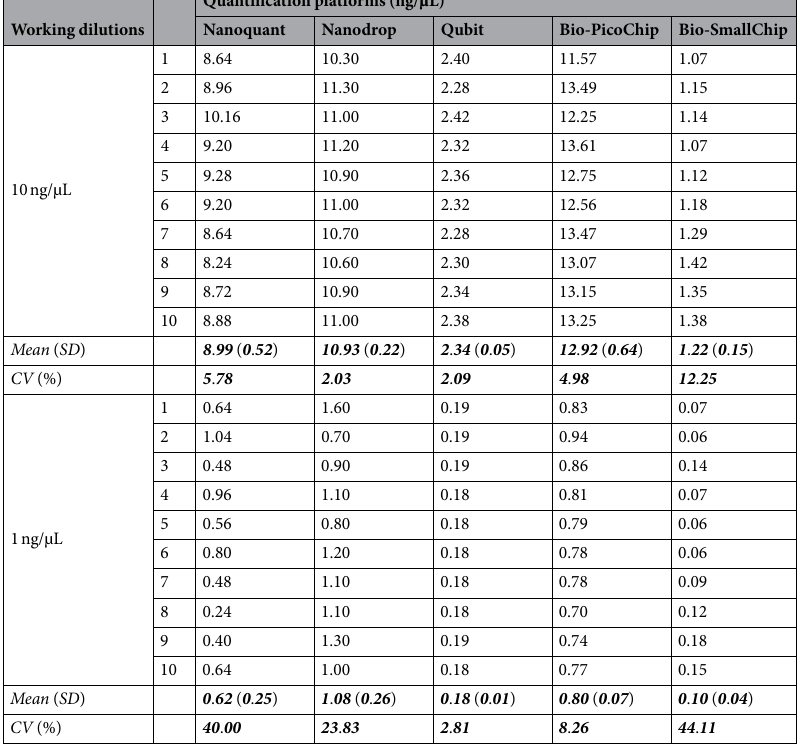
Table 1. RNA contents in miRNA-Ref samples and repeatability of four quantification platforms.